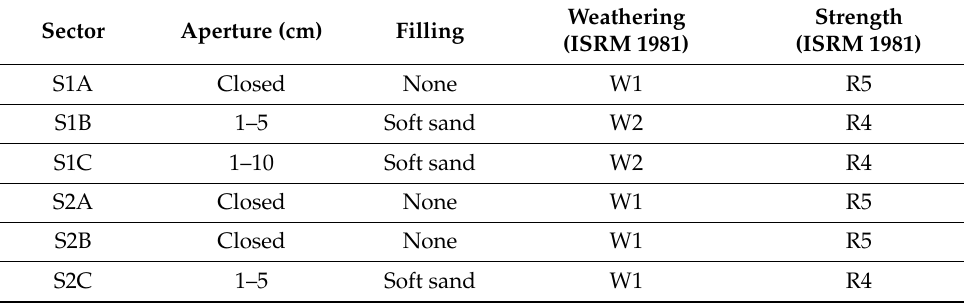
Table 8. Characteristics of the sets and rock mass for each sector in